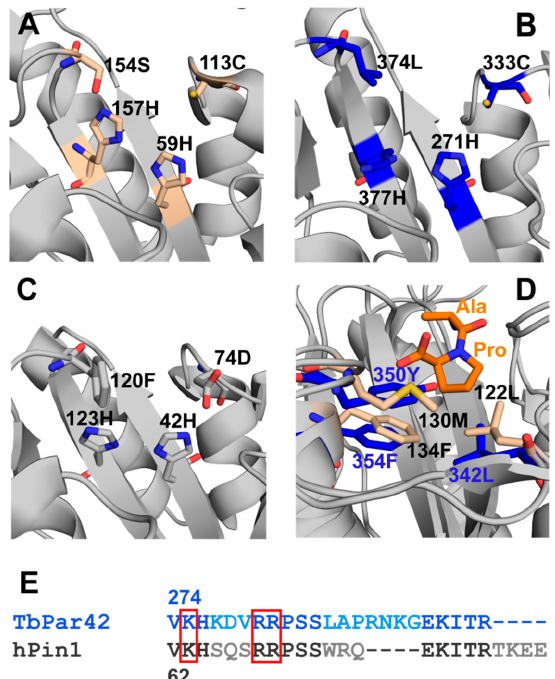
Figure 3. Structural insights into the PPIase domain of Tb Par42. Comparison of the catalytic tetrad (prominent residues are represented as sticks) of ( A ) h Pin1, PDB:1NMW, ( B ) Tb Par42, PDB:2N87, and ( C ) h Par14, PDB:3UI4. ( D ) Overlay of the solution structure of Tb Par42-PPIase (PDB:2N87) and the crystal structure of h Pin1 (PDB:1PIN), with its bound Ala-Pro dipeptide in orange. Hydrophobic residues of the proline-binding pocket are represented as sticks in blue for Tb Par42, and in beige for h Pin1. ( E ) Sequence alignment of the β 1- α 1 loop between Tb Par42 (blue) and h Pin1 (black). The phosphate group binding residues of h Pin1 are framed (red). A full alignment of both PPIase domains is found in Figure